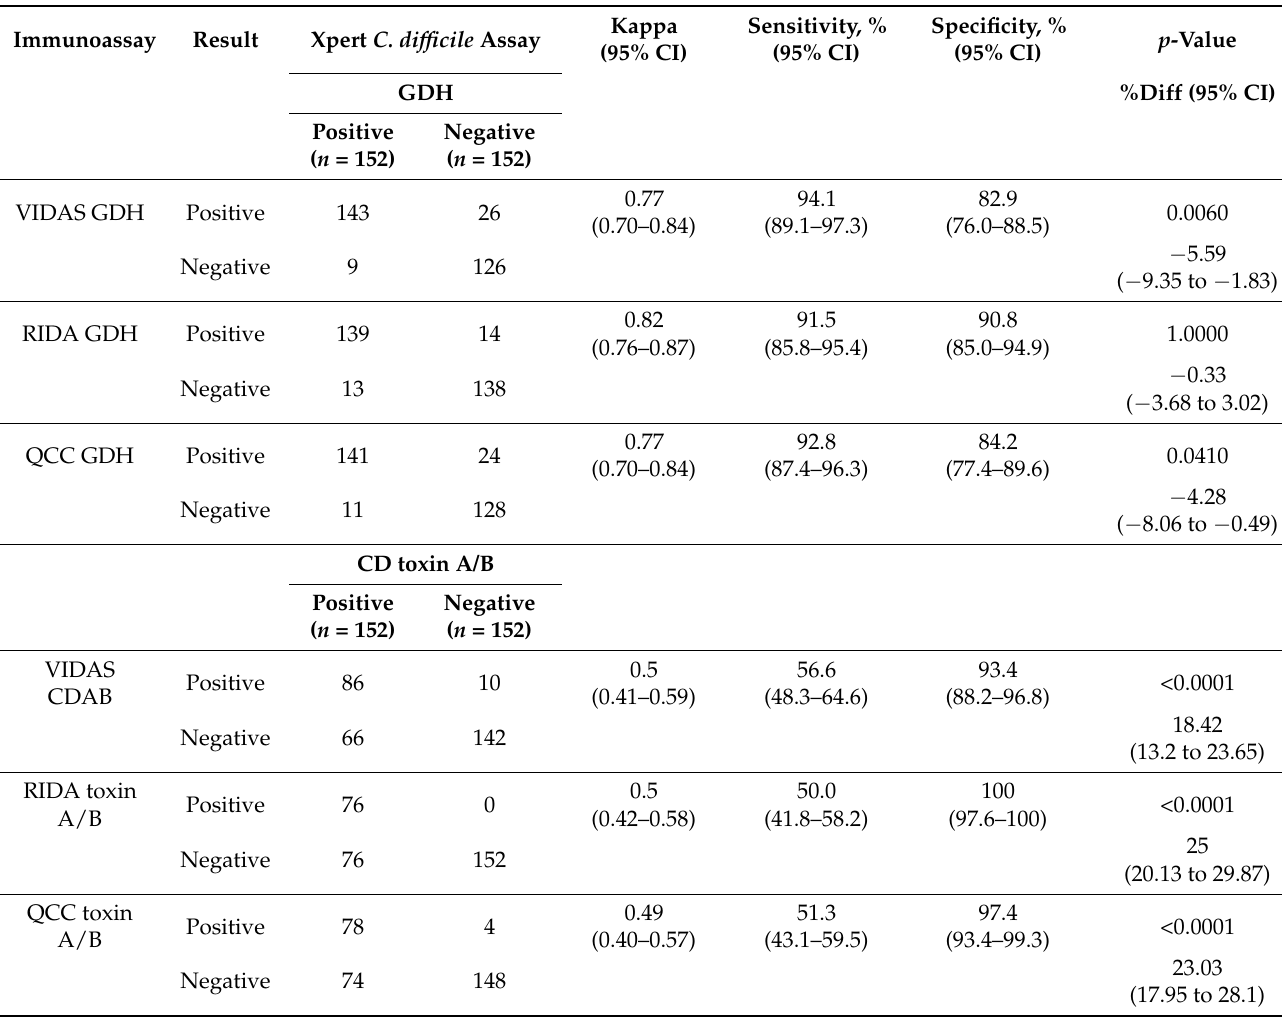
Table 3. Analytical performance results among the three immunoassays for the detection of Clostrid- ioides difficile glutamate dehydrogenase and toxin A/B, as compared with the Xpert C. difficile